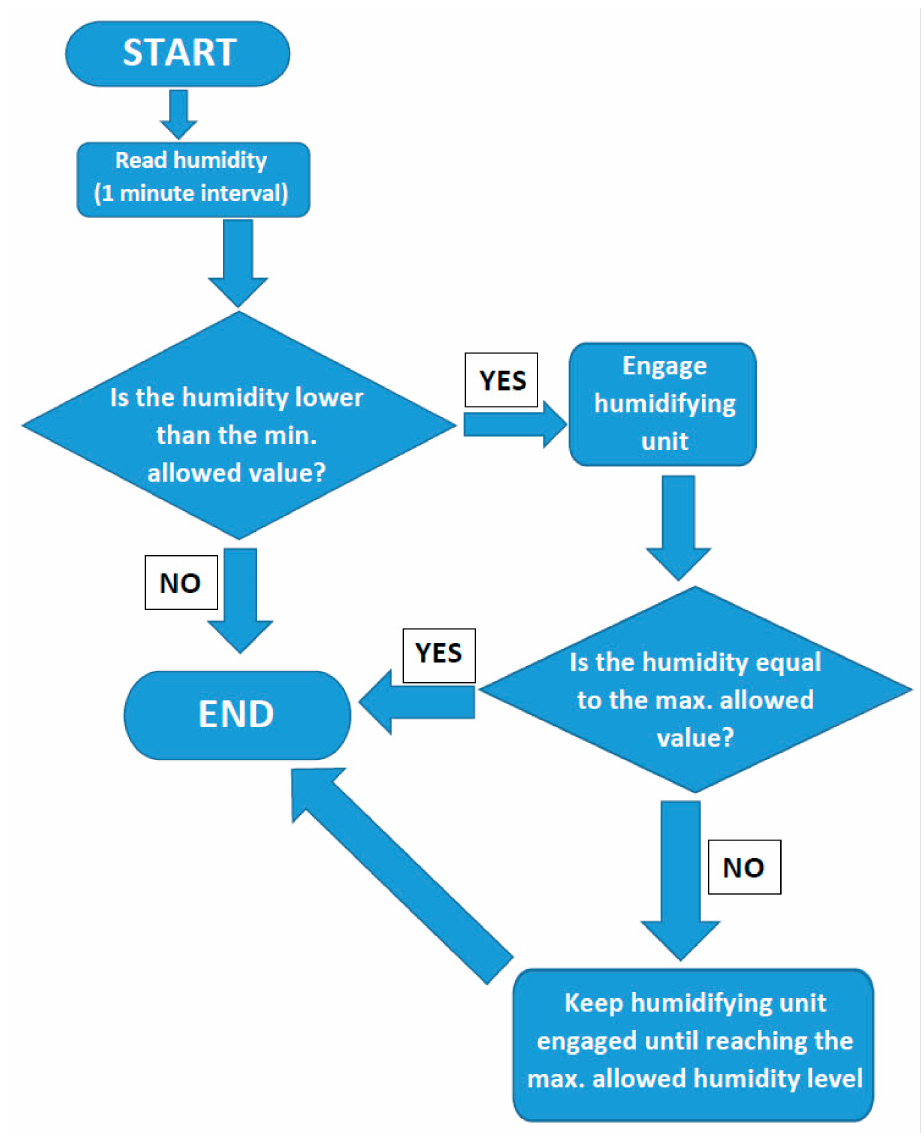
Figure 13. Structure of the humidity control